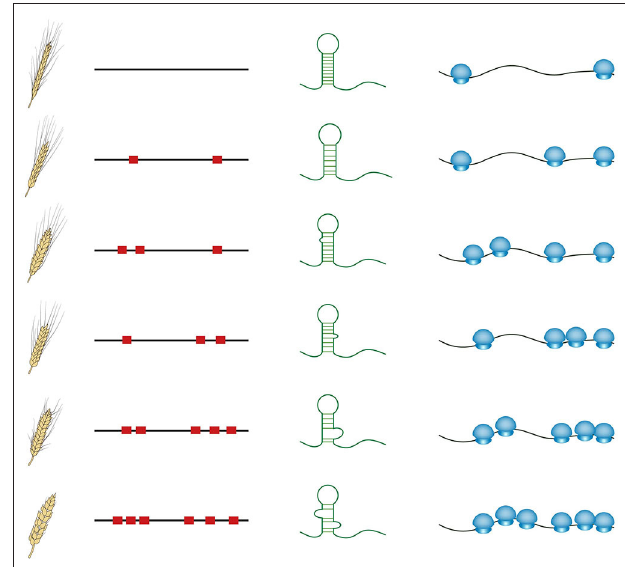
FIGURE 2 | Schematic of the diversity among phenotypes, genome sequences, RNA structures, and translational levels across natural varieties. Red squares represent the sequence variations. Small blue circles represent small ribosomal subunits, whilst big blue circles indicate large ribosomal